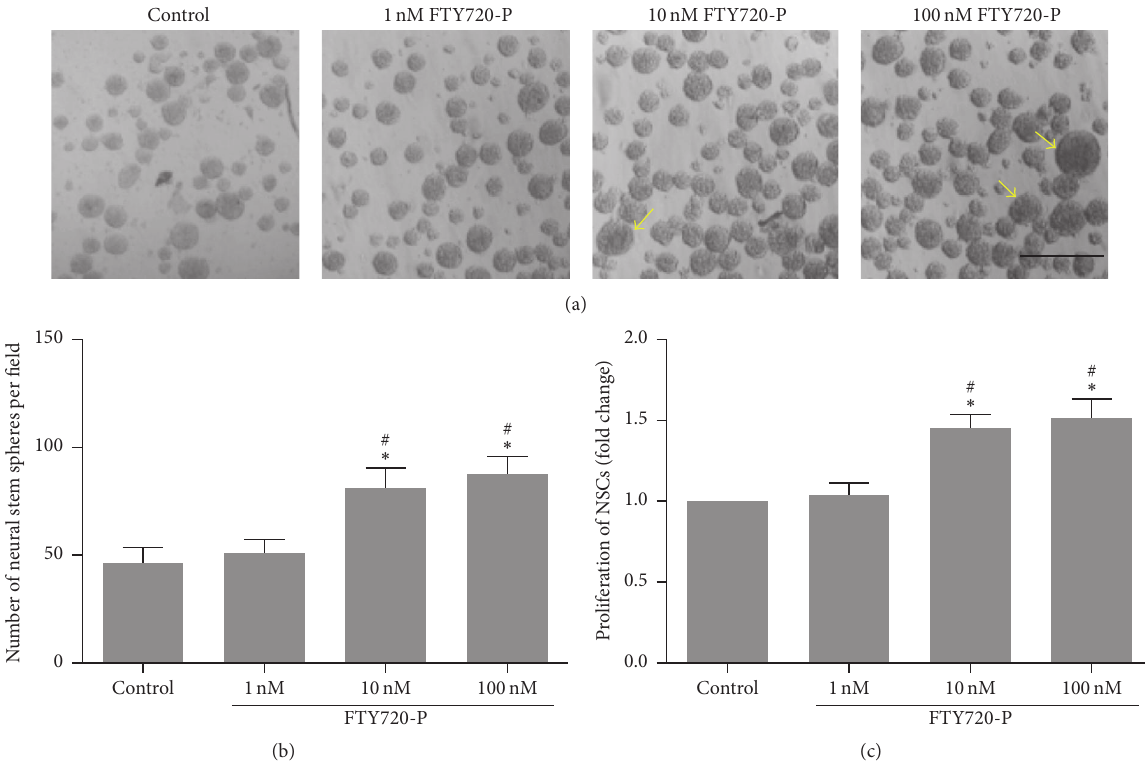
Figure 2: The proliferation of NSCs in the presence of FTY720. ((a)-(b)) Representative images of neurospheres and number quantification in response to FTY720. Bar = 500 𝜇 m. Arrows indicated lagers sizes of the neurospheres. (c) Proliferation rate indexes in the presence of FTY720. Fold changes in proliferation were calculated by the absorbance of 450 nm of CCK-8 assay. Data represent the mean ± SD; 𝑛 = 5 in each group; ∗ 𝑃 < 0.05 compared with control group; # 𝑃 < 0.05 compared with 1nM FTY720 group, by ANOVA followed by Dunnett’s multiple comparison